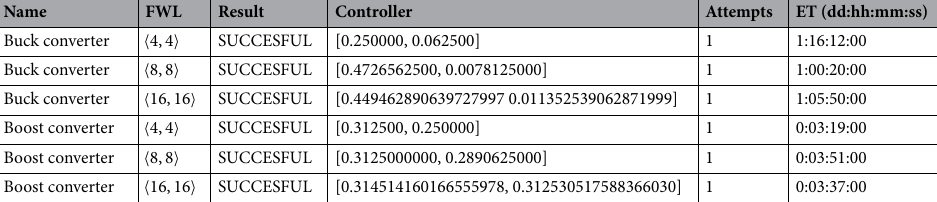
Table 4. Experiments for overshoot only. It contains information about the converter name, FWL format, synthesis result, the synthesized controller, number of attempts to synthesize the controller, and total synthesis time.